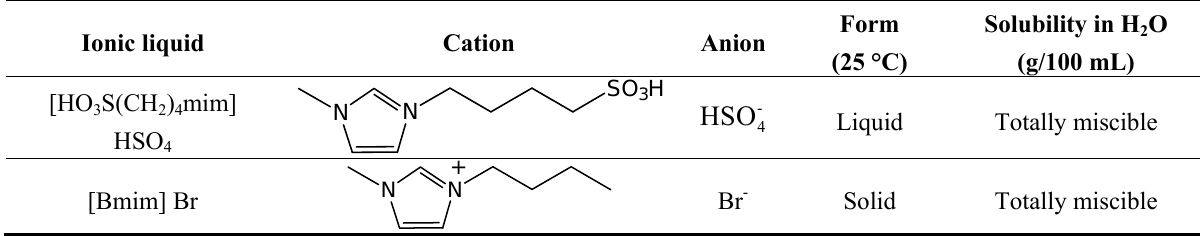
Table 4. Physicochemical properties of the ionic liquids